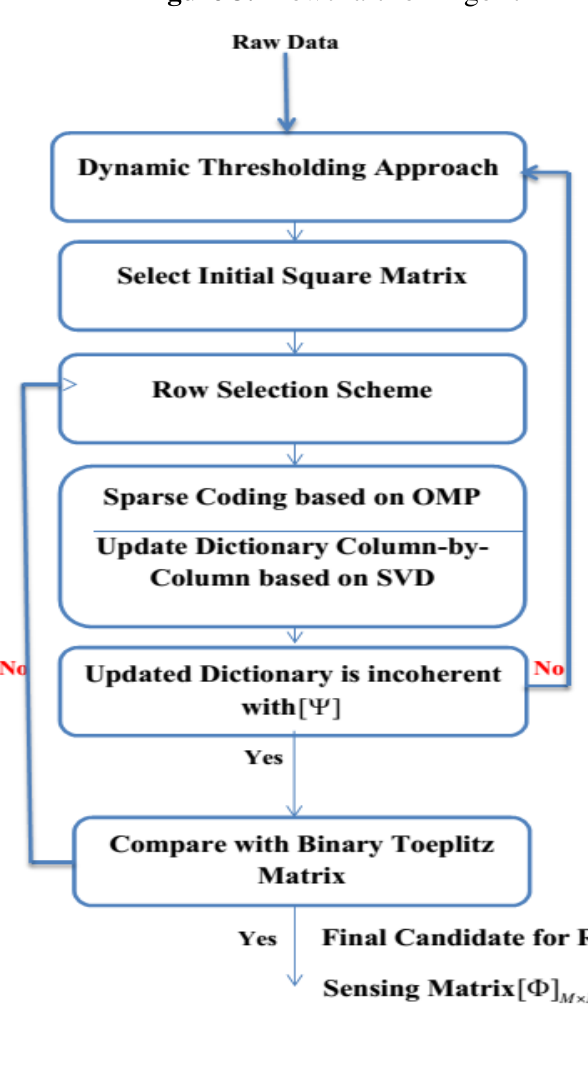
Figure 3. Flowchart for Algorithm